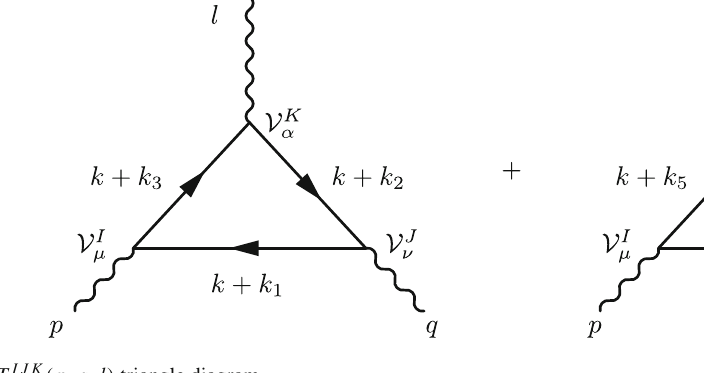
Fig. 1 The T IJK μνα ( p , q , l ) triangle